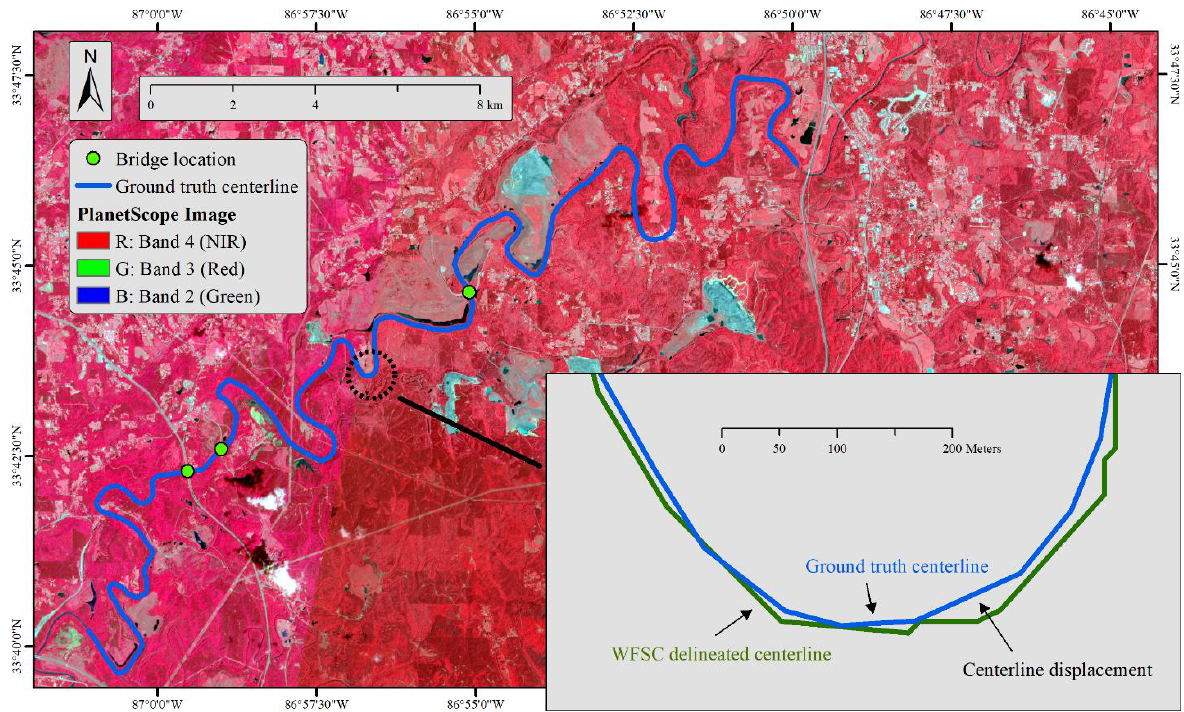
Figure 5. The spatial accuracy assessment of the centerline in the meandering lotic habitat.